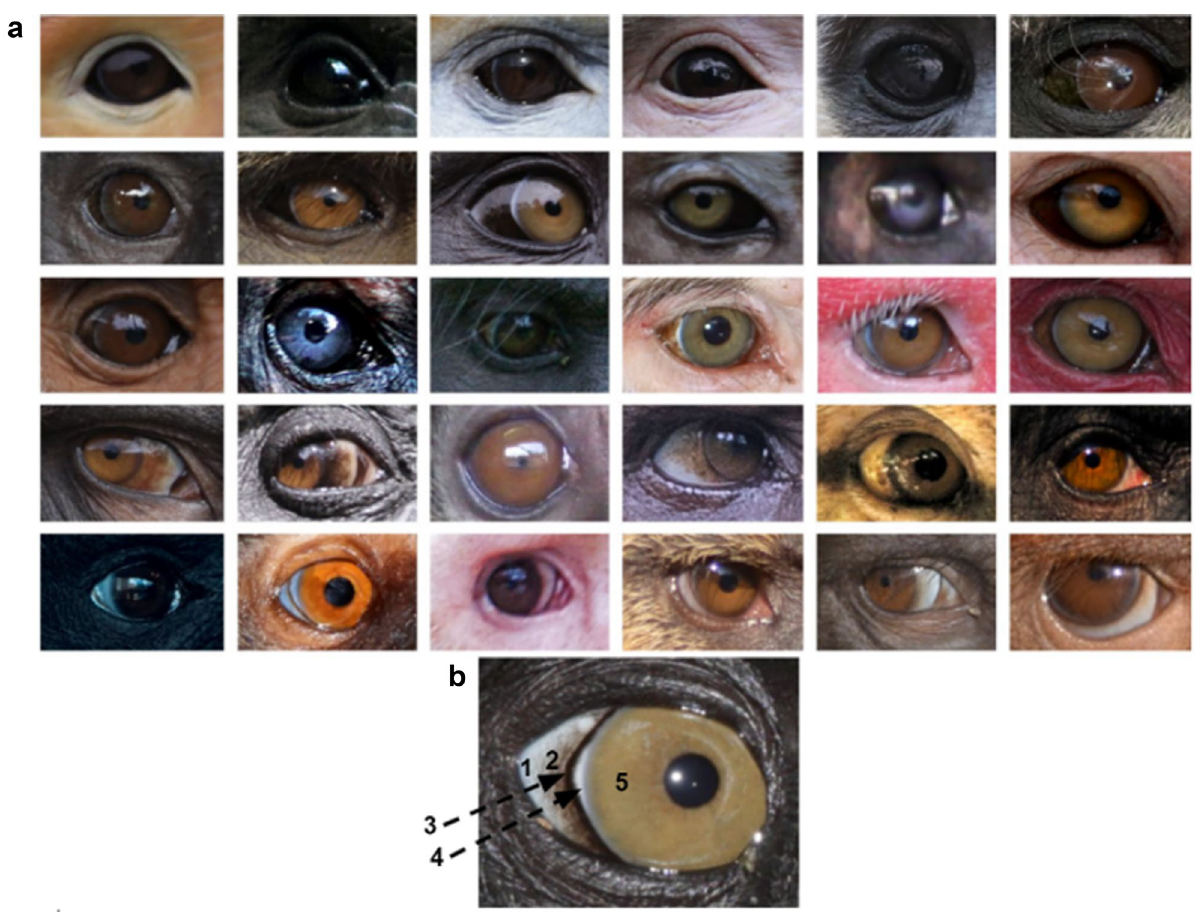
Figure 2. The eyes of anthropoid primates are extremely diverse in shape and colouration. ( a ) Species represented in this panel are, from left to right, top row: Pygathrix nemaeus, Brachyteles arachnoides, Rhinopithecus roxellana, Rhinopithecus bieti, Hylobates pileatus, Colobus guereza; second row: Trachypithecus cristatus, Papio anubis, Mandrillus sphinx, Macaca fascicularis, Ateles belzebuth, Macaca fuscata ; third row: Piliocolobus badius, Ateles hybridus, Colobus angolensis, Macaca mulatta, Cacajao calvus, Macaca fuscata ; fourth row: Theropithecus gelada, Gorilla gorilla gorilla, Aotus lemurinus griseimembra, Sapajus apella, Macaca sylvanus, Trachypithecus geei ; fifth row: Saguinus bicolor, Cebuella pygmaea, Cebus capucinus, Pithecia pithecia, Theropithecus gelada (infant), Alouatta seniculus . ( b ) Some species, like Macaca nigra represented here,